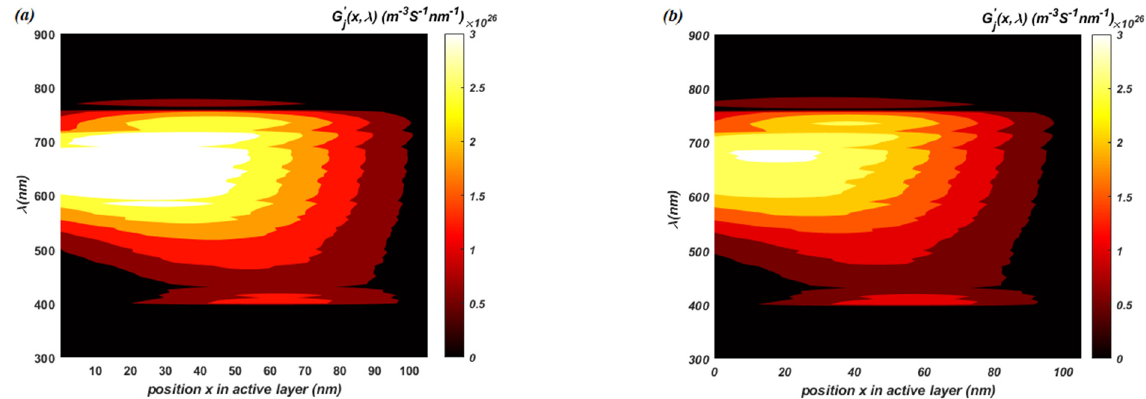
Figure 7. Contour plots of the electric field distribution (cid:3627)𝐸 (cid:3037) (𝑥)(cid:3627) verted and ( b ) in conventional OSCs.